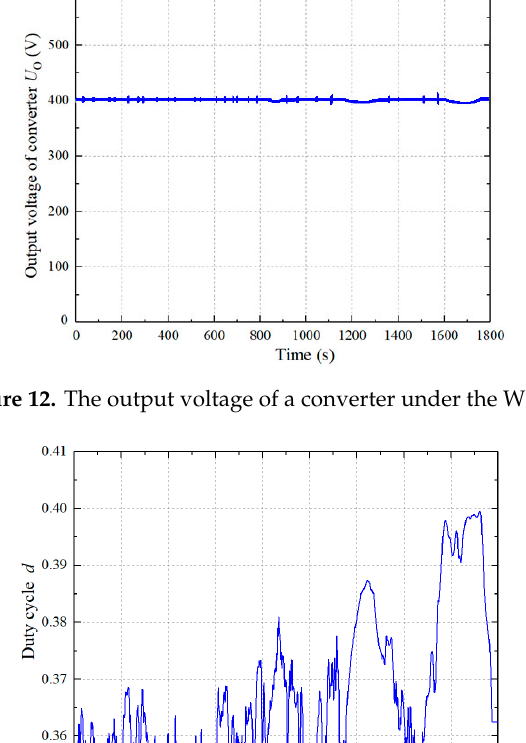
Figure 14. The experiment prototype.